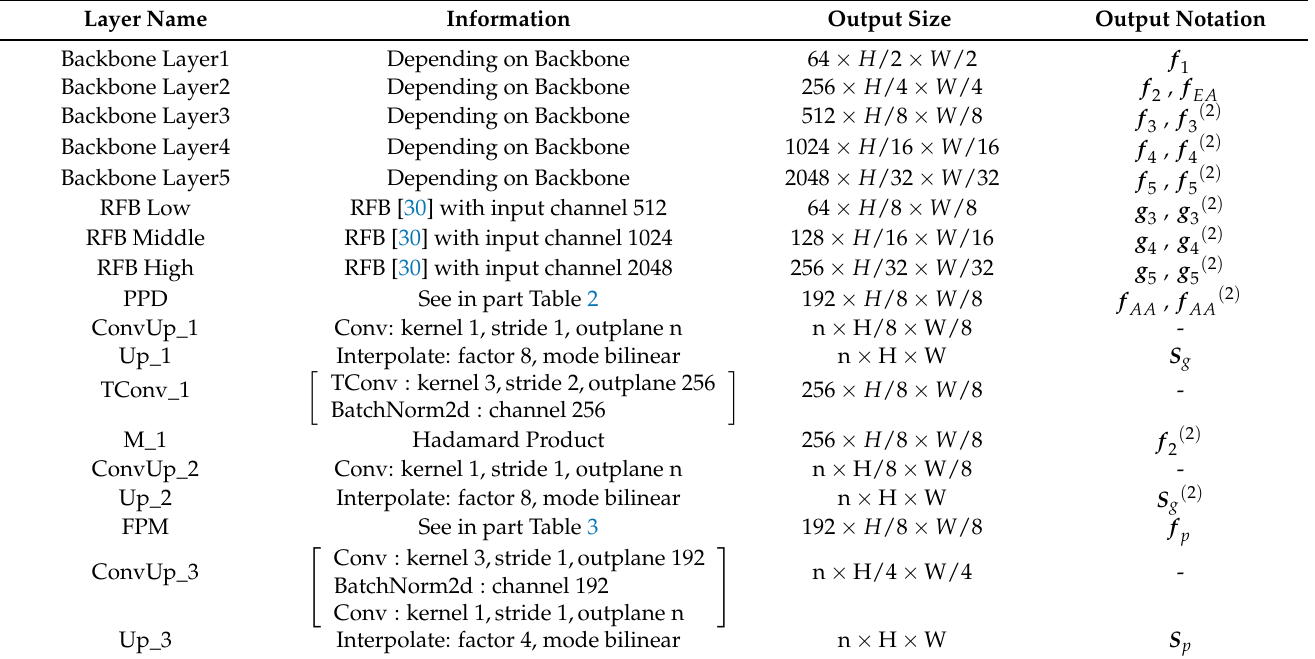
Table 1. Detailed layer information and feature maps size in Figure 1. The size of input image S I is 3 × H × W , and the size of output S p is n × H × W .